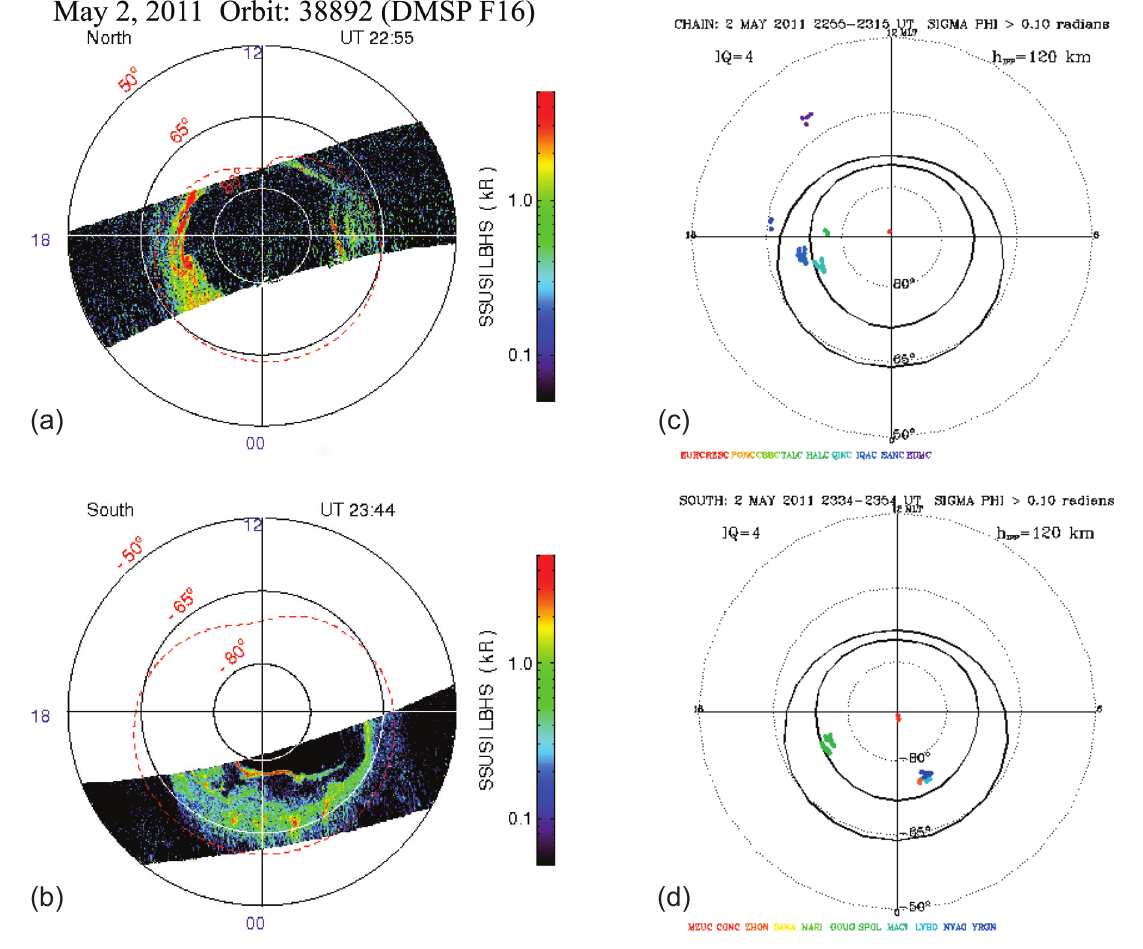
Figure 12. (a, b) Two successive SSUSI (DMSP F16) auroral image scans mapped as a function of magnetic latitude and MLT. (b, d) Corre- sponding maps of IPPs where scintillation exceeded 0.1 rad. The statistical auroral oval for moderately disturbed conditions is